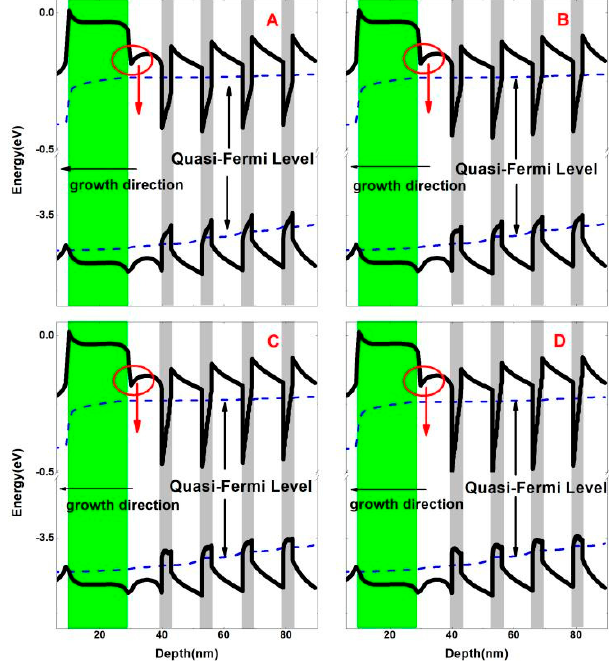
Figure 3. Energy-band structures of samples A , B , C and D .